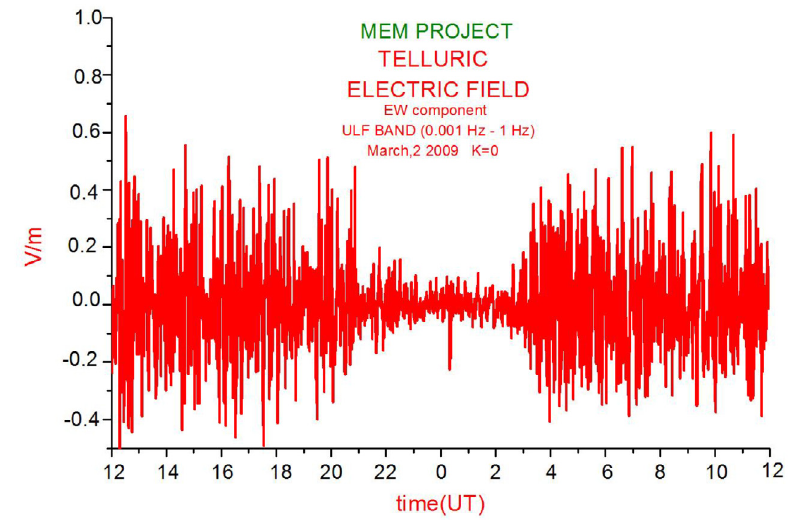
Figure 19. Diurnal variation of electric field noise adopted from Di Lorenzo et al. [2011].